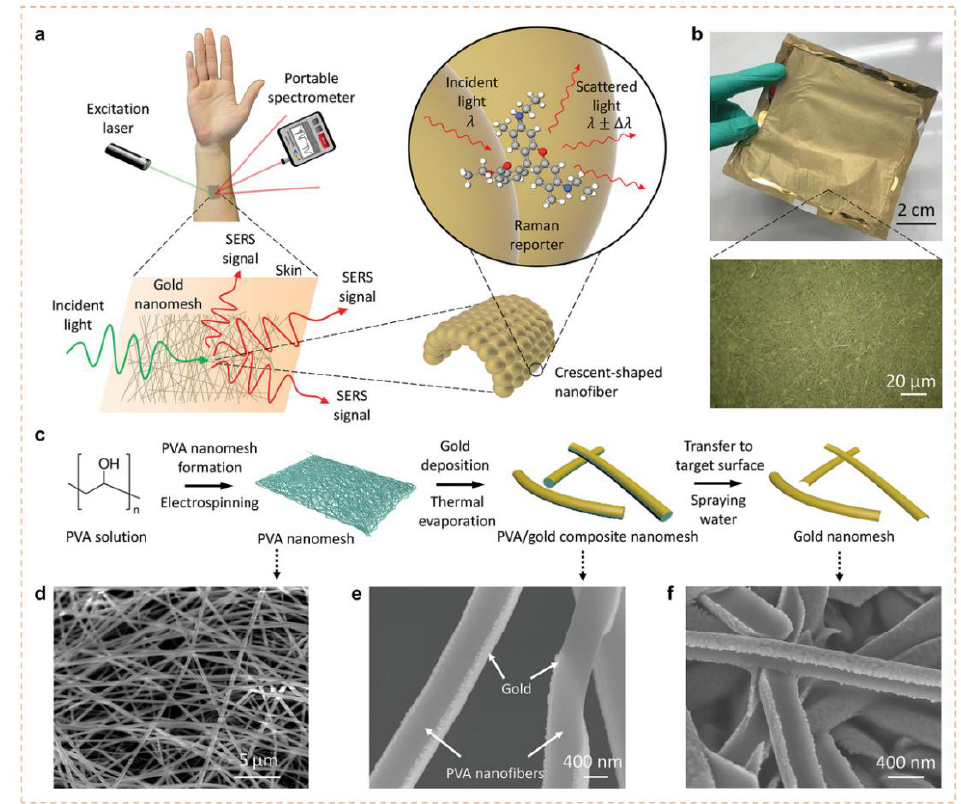
Figure 4. Design, characterisation and fabrication of wearable SERS sensor for detection of sweat biomarkers ( a ). Scheme representing the design and idea of wearable SERS sensor on skin; ( b ). Image of the gold nanomesh fabricated. Inset depicts the optical microscopy image of the gold nanomesh (50X); ( c ). Scheme representing the development procedure of nanomesh by electrospinning and further treatment process of the gold nanomesh; SEM micrograph of the ( d ). PVA fiber nanomesh; ( e ). Gold coated PVA fiber nanomesh; ( f ). Gold nanomesh after eliminating the PVA fibers. (Reprinted from [109] which is an open access article distributed under the Creative Commons Attribution